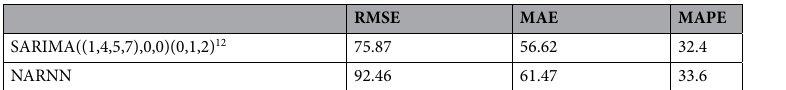
Table 3. Fitting accuracy values of the SARIMA((1,4,5,7),0,0)(0,1,2) 12 model and the NARNN model.